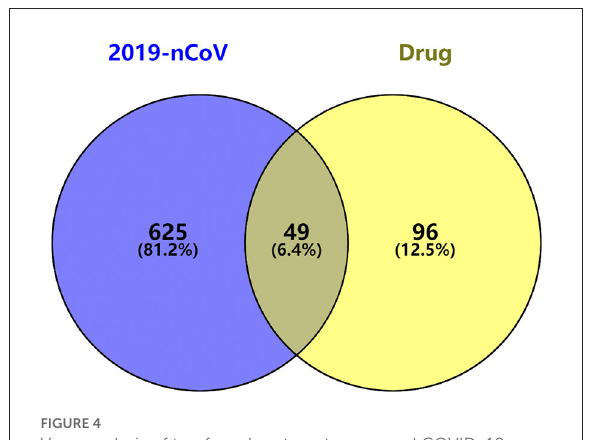
the results, the targets such as ALB, EGFR, HSP90AA1, and SRC interact with multiple targets and maybe the core